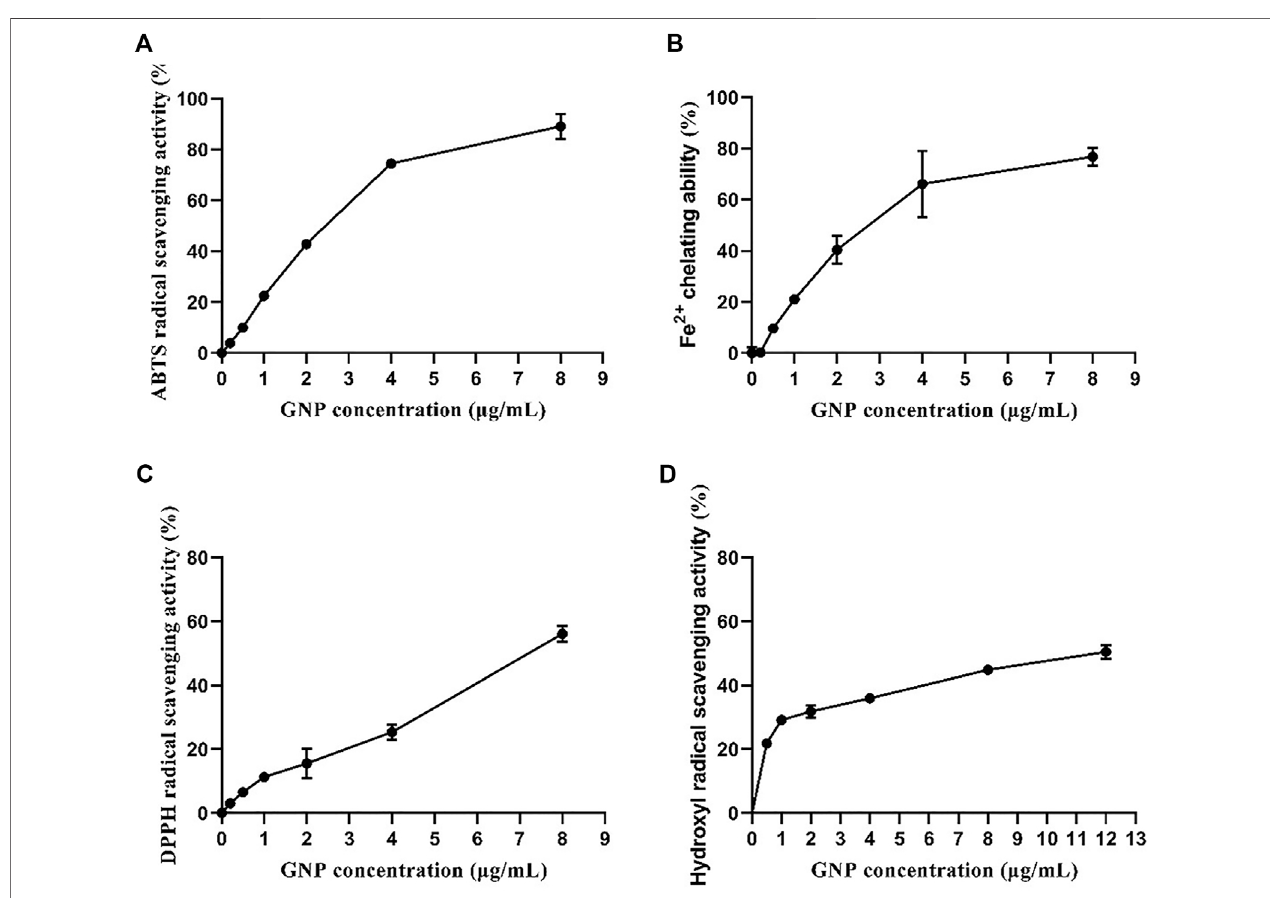
FIGURE 3 | In vitro antioxidant activities of GNP. (A) ABTS radical scavenging activity, (B) Fe 2+ chelating capacity, (C) DPPH radical scavenging activity, and (D) hydroxyl radical scavenging activity. Data are expressed as mean ± SD (n (cid:1) 3).